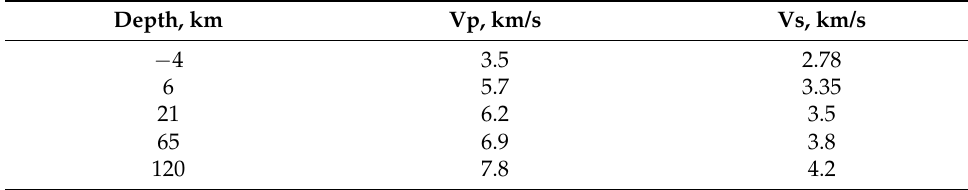
Table 1. One-dimensional reference